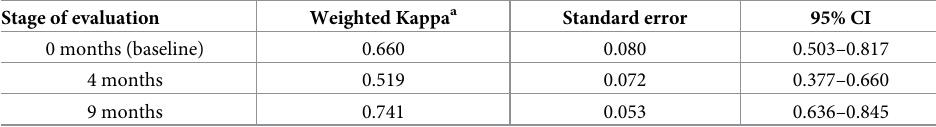
Table 3. Inter-rater agreement between CDAI and DAS 28 at 3-time points of disease activity assessment. Stage of evaluation Weighted Kappa